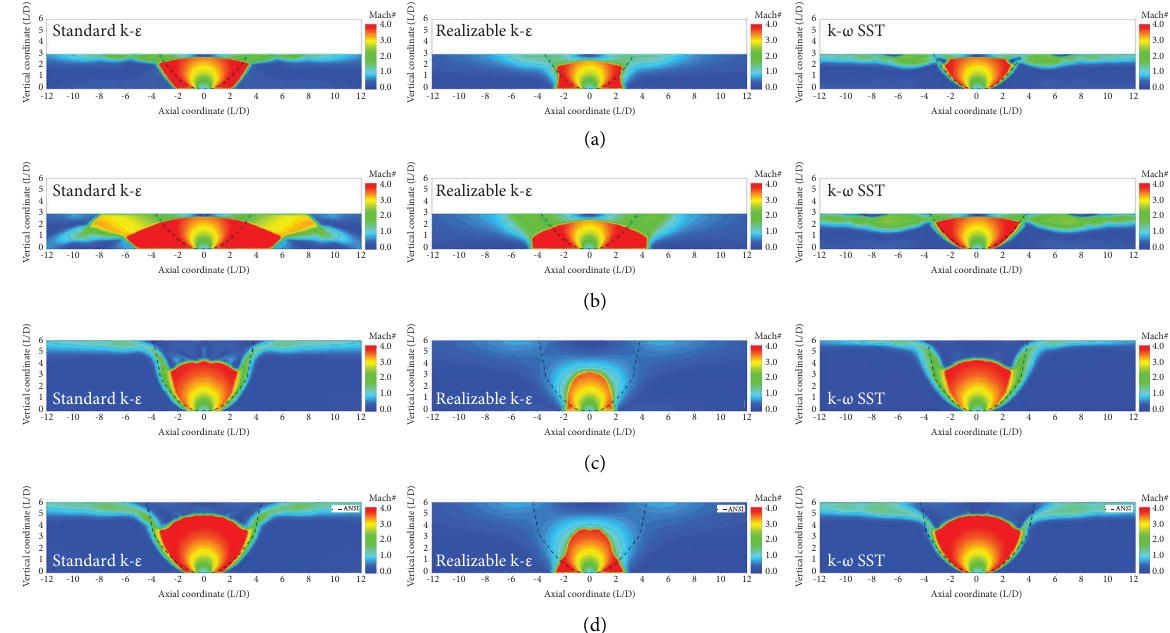
Figure 8: Distribution of the Mach number on the front-view: (a) gap 3mm, P P 0 � 70 bar, and (d) gap 6mm, P 0 �